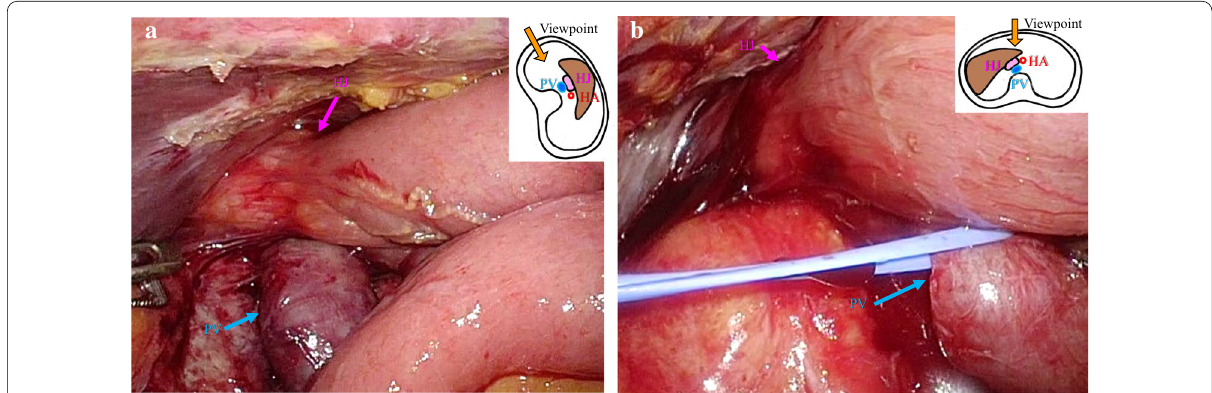
Fig. 3 Laparoscopic findings of the hepatic hilum during laparoscopic pancreatoduodenectomy. In the left lateral decubitus position ( a ), the portal vein (PV) was easily encircled beneath the hepaticojejunostomy (HJ). In contrast, in the supine position ( b ), the jejunal loop covered the PV and hindered its